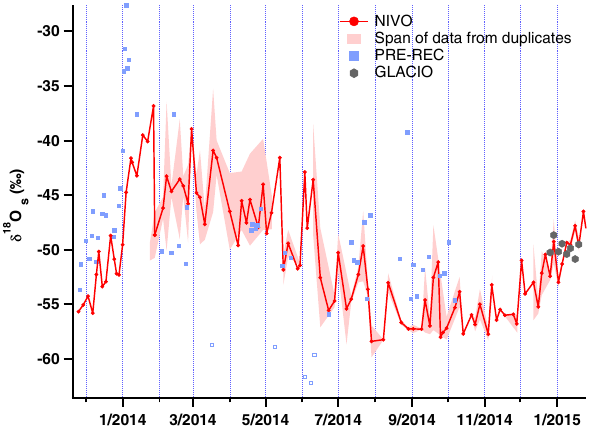
Figure 4. Comparing surface snow isotopic composition for 2014 from the NIVO dataset (red dots and line; duplicate span repre- sented by the red shade, corresponding to the green line in Fig. 3) with measurements obtained by different campaigns: PRE-REC (blue squares) and GLACIO (grey hexagon). PRE-REC outliers are marked by unfilled squares. For details over the different cam- paigns’ protocols, see Sect. 2.2 and Table